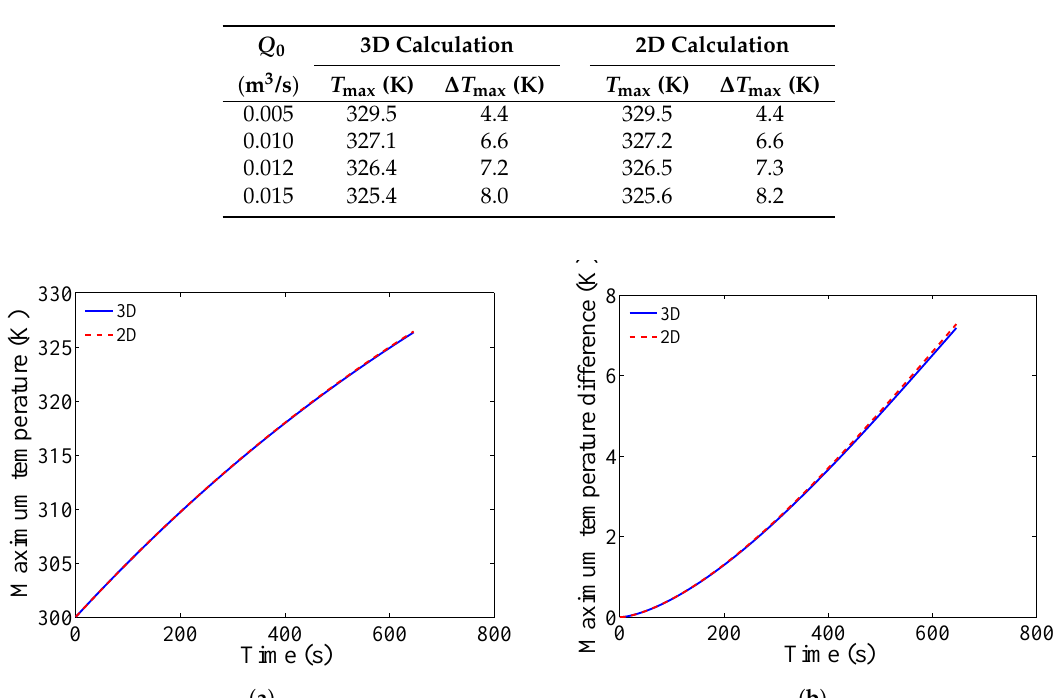
Figure 5. Comparison of the numerical results by 2D calculation and 3D calculation. ( a ) Maximum temperature; ( b ) maximum temperature difference.